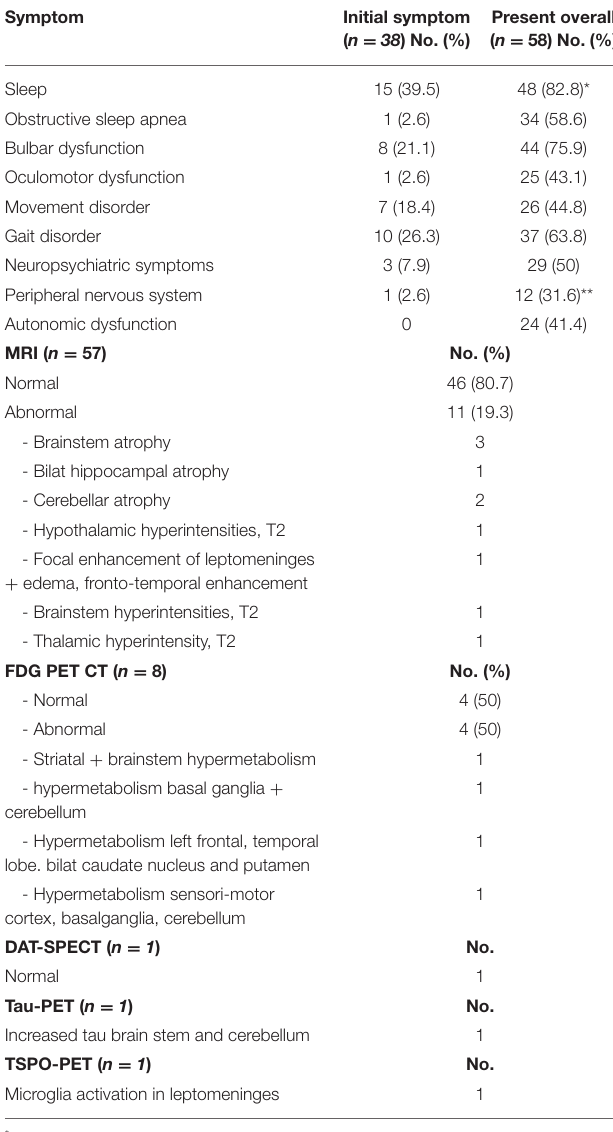
( Table 2 ). An overview of symptoms and their association is provided in Figure 1